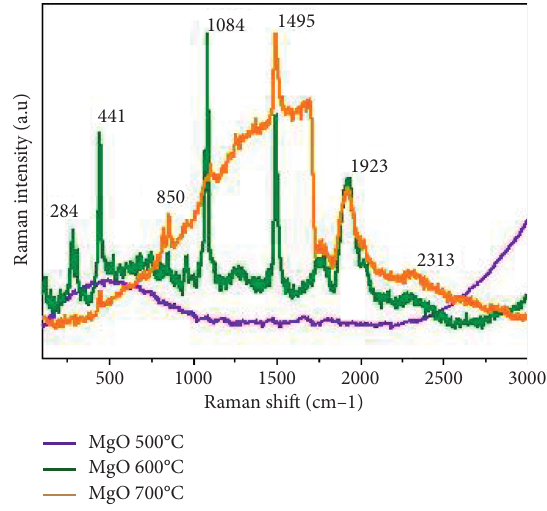
Figure 10: Micro-Raman spectra of MgO